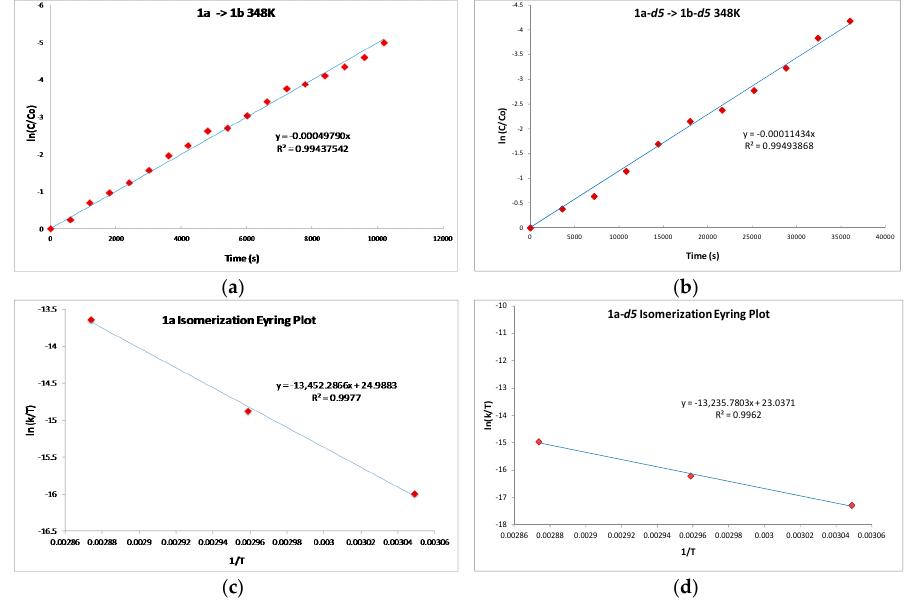
Figure 1. ( a ) Plot of rate of consumption of 1a at 348 K; ( b ) Plot of rate of consumption of 1a – d5 at 348 K; ( c ) The Eyring Plot for conversion of 1a to 1b ; ( d ) The Eyring Plot for conversion of 1a – d5 to 1b – d5 .